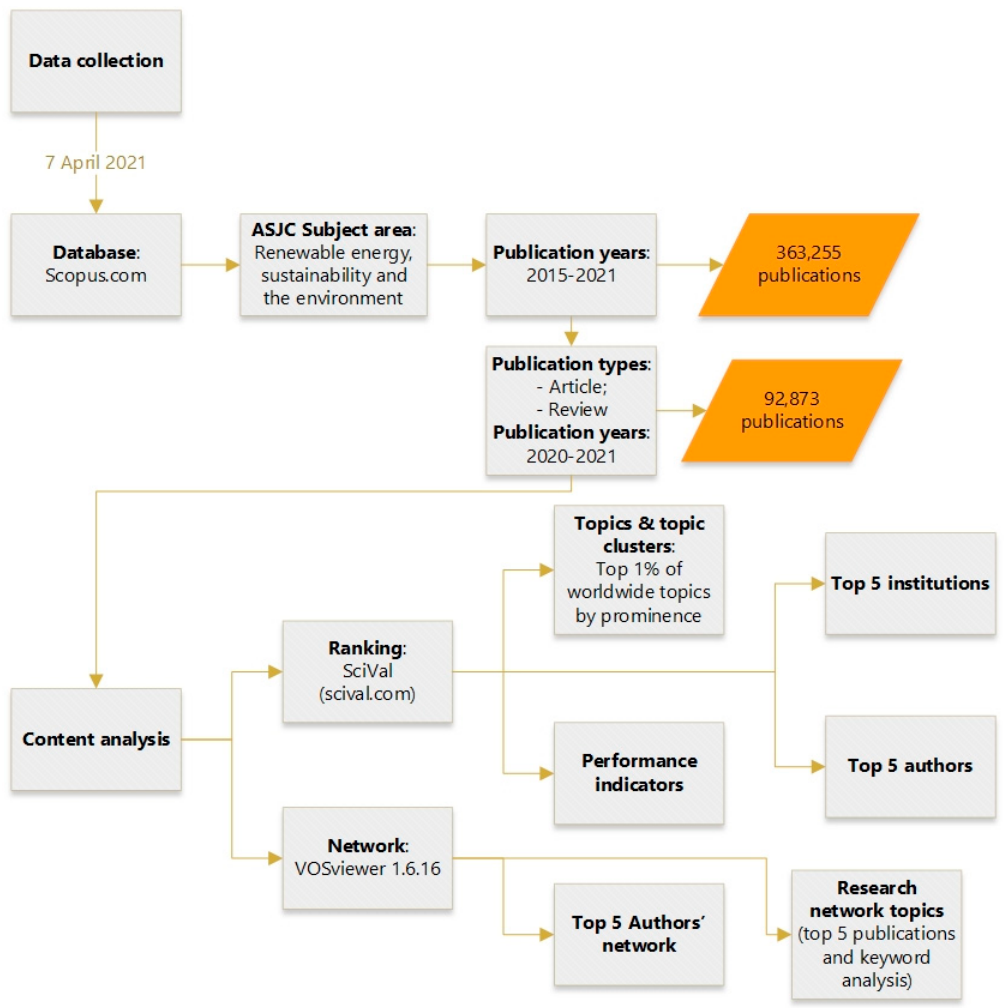
Figure 1. Diagram of the general research methodology.